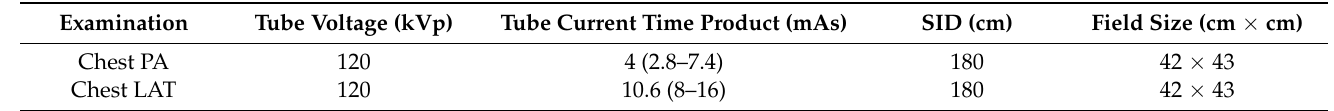
Table 1. The exposure condition based on the latest Korean national survey to update the national DRLs for general radiographic examinations in